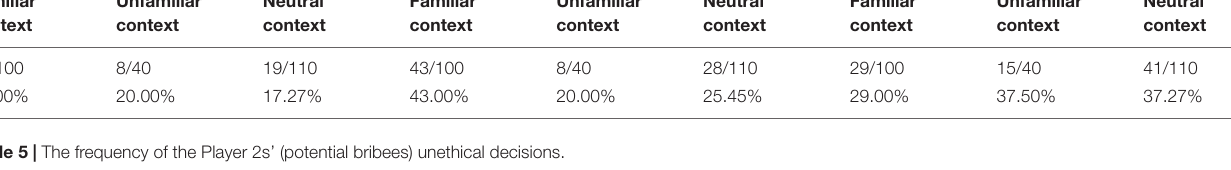
No more than one time (attempts <= 1/15)